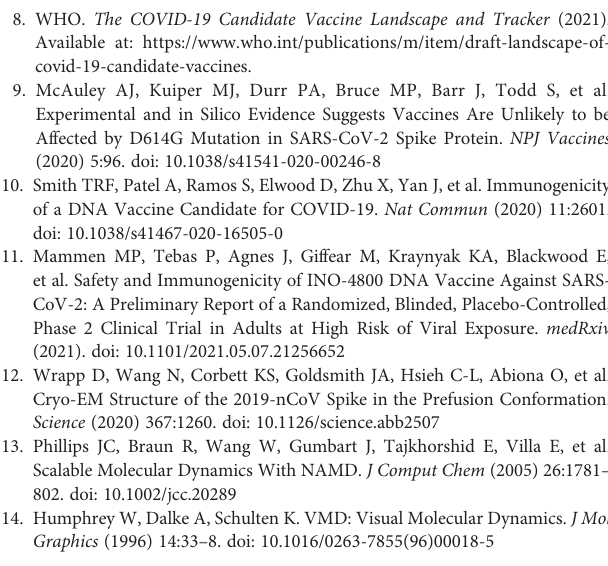
Supplementary Figure 1 | Outline of serum sample generation timeline. Ferrets (n=3 male, n=3 female) were vaccinated with INO-4800 on Day 0 and Day 28 of the study (green dates). Serum samples used for neutralisation assays were collected on Day 35 (n=2 each from male and female) or 42 (n=1 each from male and female) of the study. The parent study continued beyond Day 42, and is not described in this manuscript. Supplementary Figure 2 | Structure of ACE2 binding to the SARS-CoV-2 Spike receptor-binding domain of variant 501Y.V2. Modelling suggests the lysine to asparagine mutation, (K417N), may facilitate additional hydrogen bonding to the ACE2 receptor, (Angiotensin-converting enzyme 2), via binding through an N-linked glycoside at position asparagine Asn90 in ACE2. [In this case modelled as Beta-D- GlcNAC (1->4) GlcNAC]. The relative position of the other 501Y.V2 mutations in the receptor-binding domain (Tyr501 and Lys484) as also shown. Supplementary Figure 3 | Structure of ACE2 binding to the SARS-CoV-2 Spike receptor-binding domain showing a close up of the N-terminal domain region, highlighting the salt bridges between arginine and aspartic acid at positions Arg78- Asp80 and Arg214-Asp215. In the 501Y.V2 variant, aspartic acid 80 is mutated to alanine (D80A) and aspartic acid 215 is mutated to glycine (D215G), losing both salt bridges, altering the relative positions of the arginine residues, as shown in Figure 2E ). The asparagine N-linked glycosylation attachment point Asn74 is also labelled in the